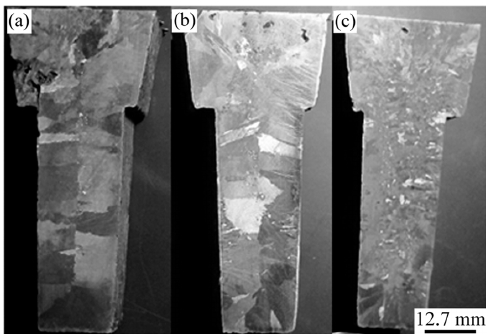
Figure 1. Macrostructure of an as-cast Fe-Mn-Al-C austenitic steel containing different cerium contents: ( a ) 0%, ( b ) 0.05%, and ( c ) 0.1%, reproduced from Reference [31], with permission of Springer,